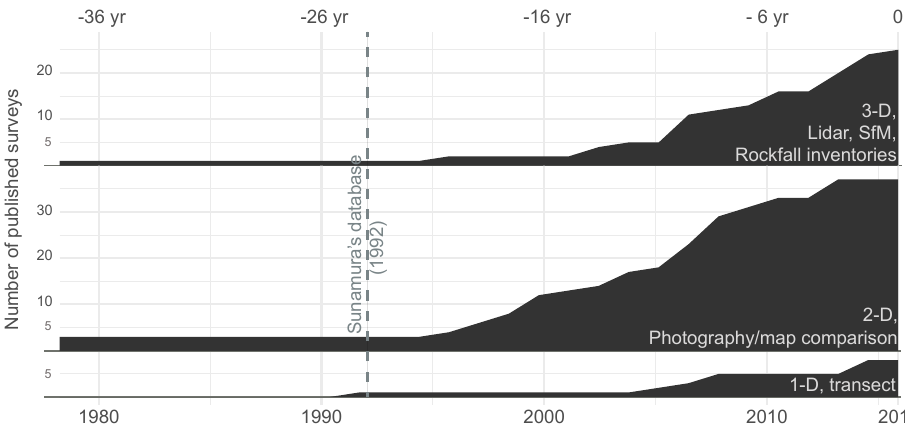
Figure 5. Time line of cliff erosion publications recorded in GlobR2C2 differentiated by measurement